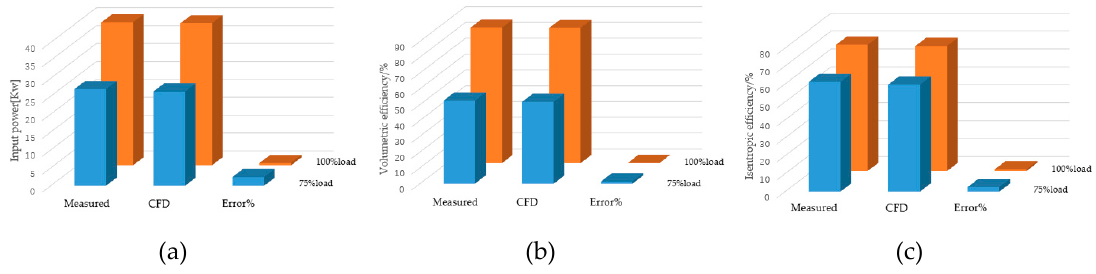
Figure 15. Comparison of the compressor performance under two working conditions. ( a ) Input power; ( b ) Volumetric efficiency; ( c ) Isentropic efficiency.